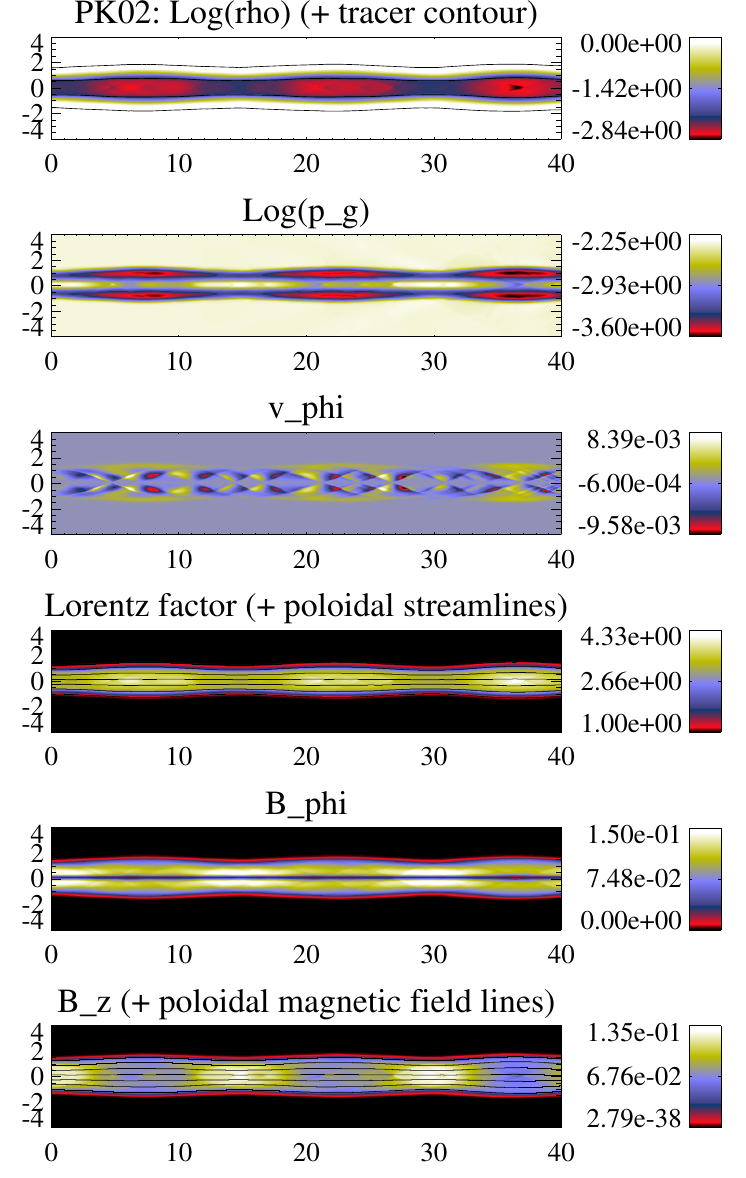
Figure 5. Steady structure of the Poynting-flux-dominated jet PK02. Panel distribution as in Figure